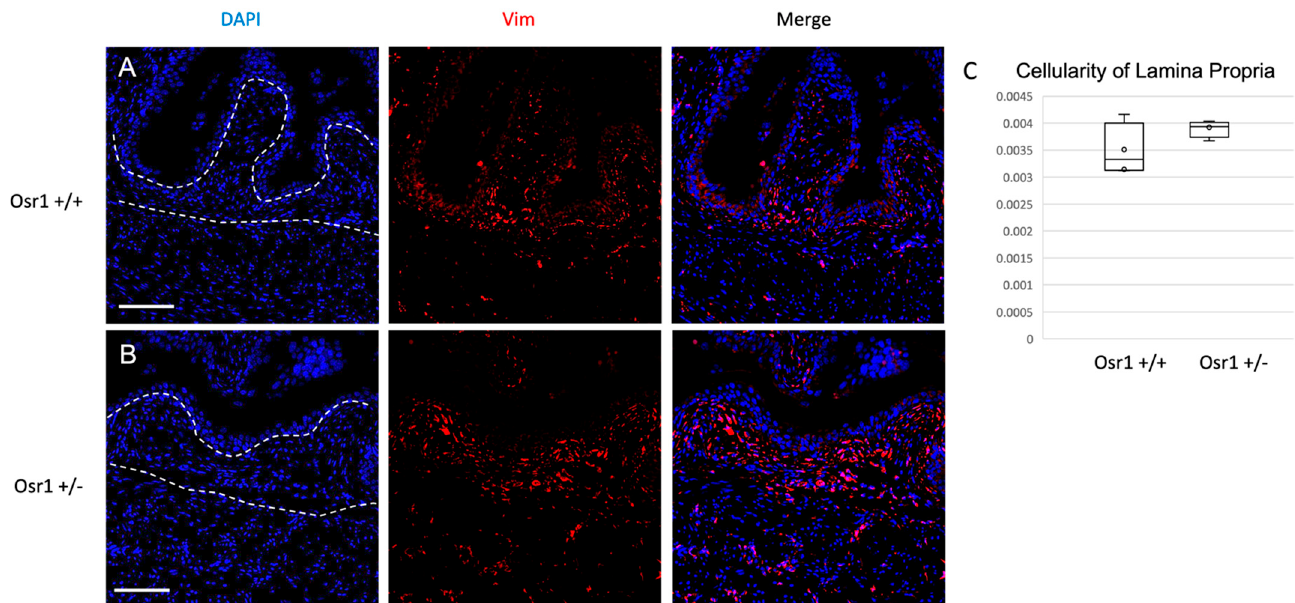
Figure 6. Osr1 +/ − and Osr1 +/ − adult mice have similar number of cells in the lamina propria: Immunofluorescent staining for Vimentin protein (red) and DAPI (blue) shows a similar number of Vimentin-positive cells in the lamina propria of the Osr1 +/+ mouse bladder ( A ) compared to Osr1 +/ − ( B ). ( C ) Cellularity was quantified by counting Vimentin-positive cells normalized to total lamina propria area in each section ( n = 3 mice/genotype). Scale bar = 100 µ m. Dotted lines delineate lamina propria.